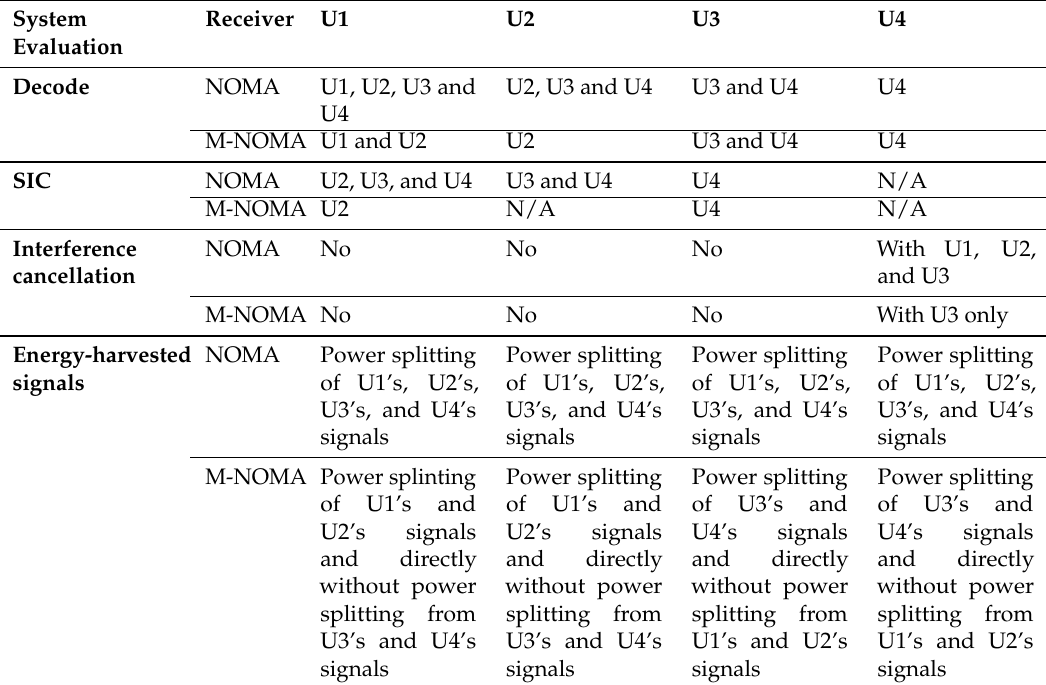
Table 1. Assessment of the individual energy-harvesting capability of NOMA and BEEM-NOMA. SIC, successive interference